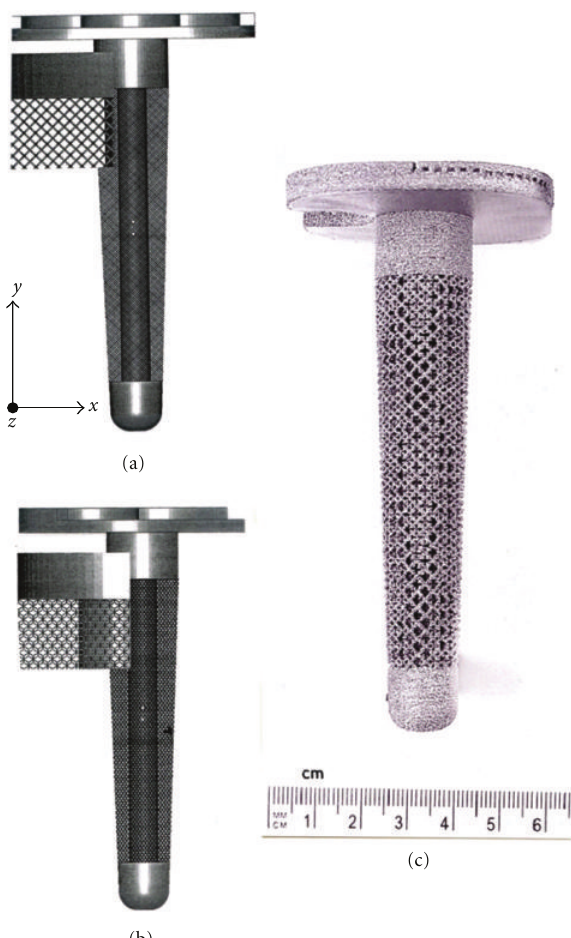
Figure 8: Tibial (knee) Ti-6Al-4V stem, monolithic prototype development example. (a) CAD model orientation with respect to the solid stem (core) axis. Mesh structure is based on dode-thin element in Figure 2(a). (b) EBM-fabricated prototype using CAD model in (a). (c) CAD model in (a) rotated 45 ◦